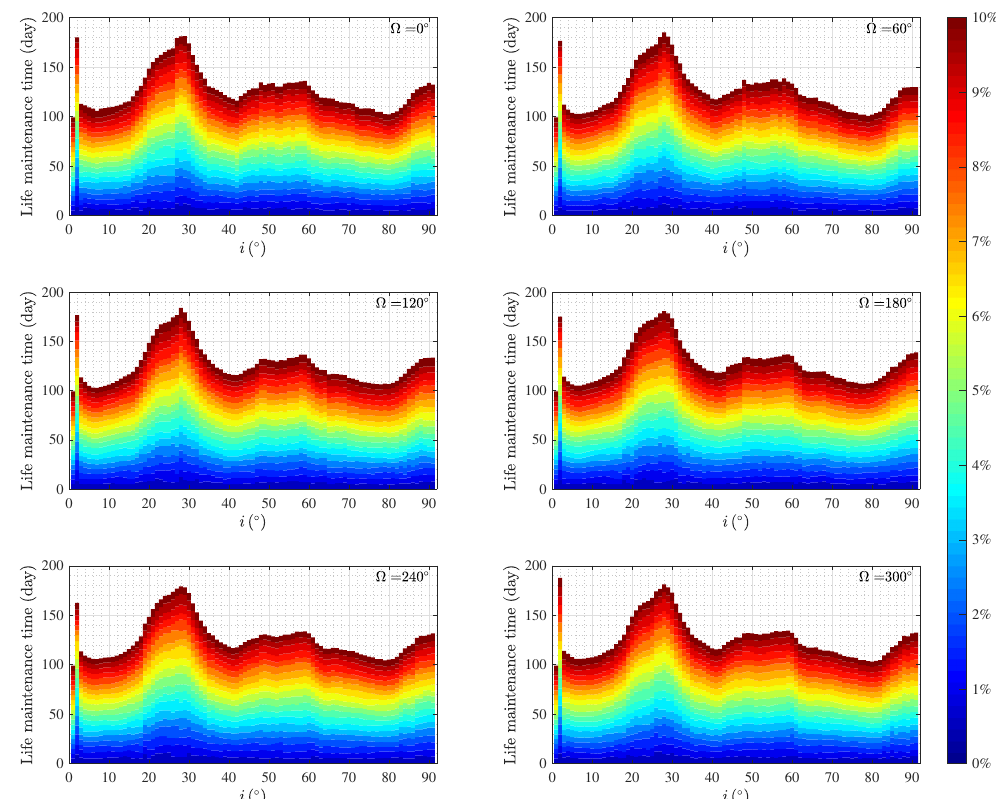
Figure 12. The bar of initial inclination verses life maintenance time with different initial RAAN. the six pictures represent Ω = 0 ◦ , Ω = 60 ◦ , Ω = 120 ◦ , Ω = 180 ◦ , Ω = 240 ◦ and Ω = 330 ◦ ,